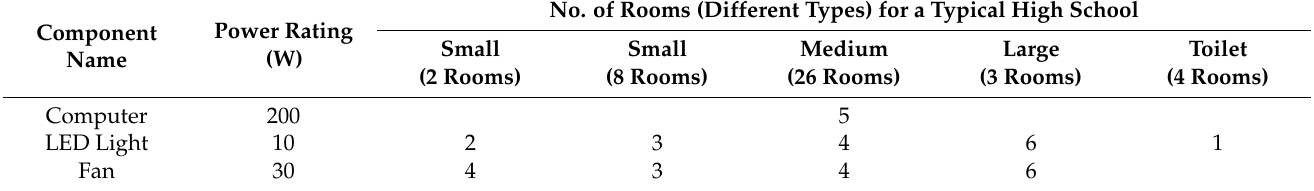
Table 1. Power rating and components for different types of classrooms in a high school.